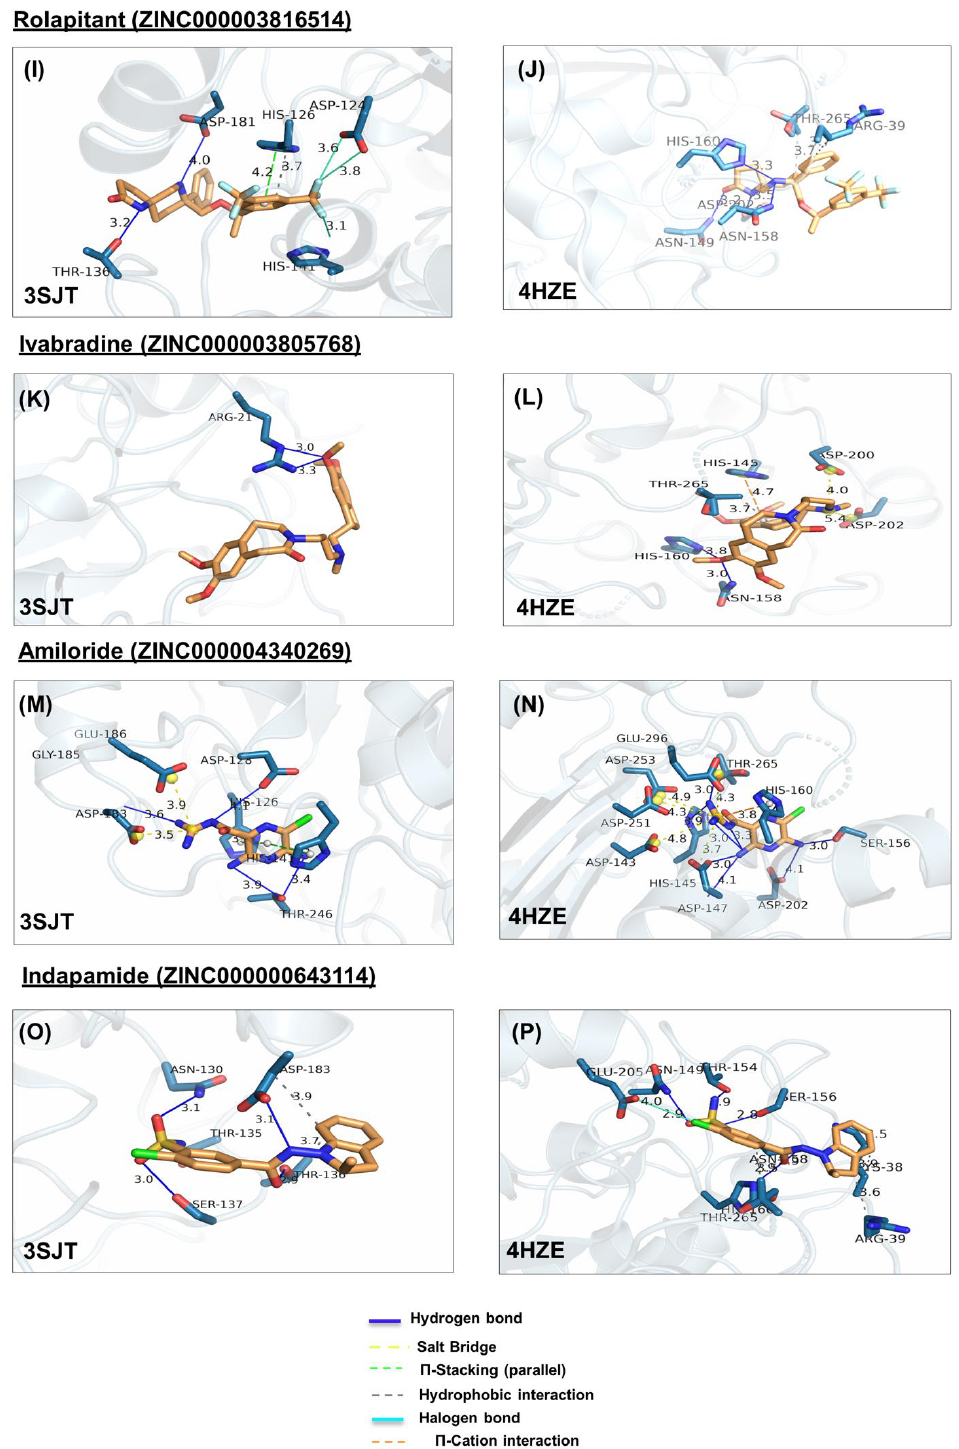
Figure 4. Ligand poses in arginase binding site. ( A , B ) Shown is the interaction of the top pose of can- desartan with ARG1 and ARG2, ( C , D ) interaction with the top pose of metformin. ( E , F ) Interaction of the top pose of isavuconazole. ( G , H ) Interaction of ARG1 and ARG2 with the best-docked pose of ligand irbesartan. ( I , J ) Interaction of best-docked pose of ligand rolapitant with ARG1 and ARG2. ( K , L ) Interaction of ARG1 and ARG2 with the best-docked pose of ligand ivabradine. ( M , N ) Interac- tion of best-docked pose of ligand amiloride with ARG1 and ARG2. ( O , P ) Interaction of ARG1 and ARG2 with the best-docked pose of ligand